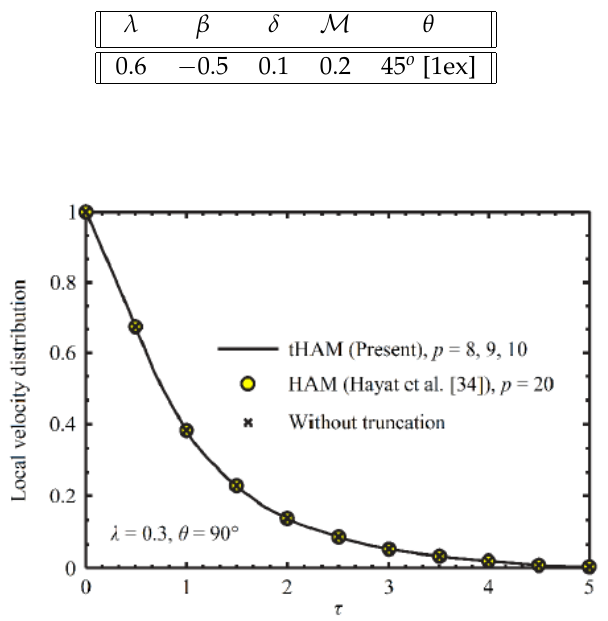
Figure 1. Verification of the local velocity distribution